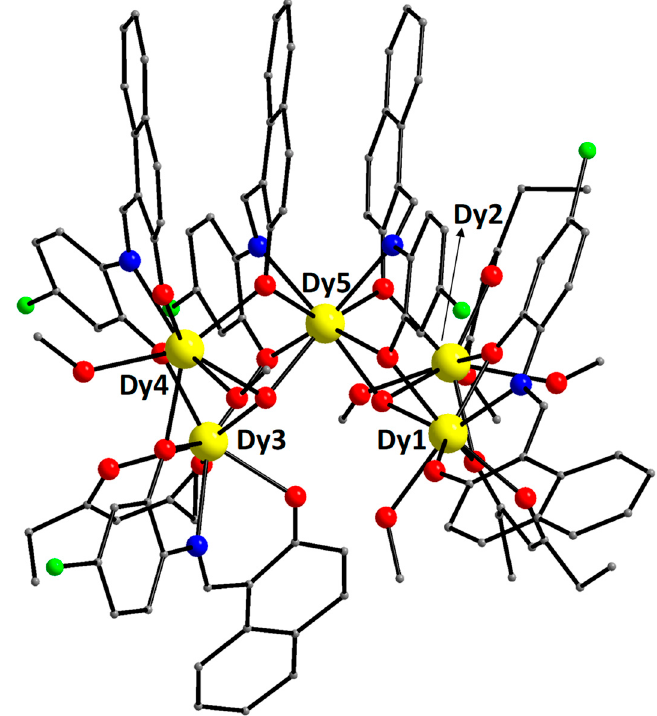
Figure 1. Partially labeled representation of the molecular structure of 1 . Color scheme: Dy III , yellow; Cl, purple; O, red; N, green; C, gray. H atoms are omitted for clarity.